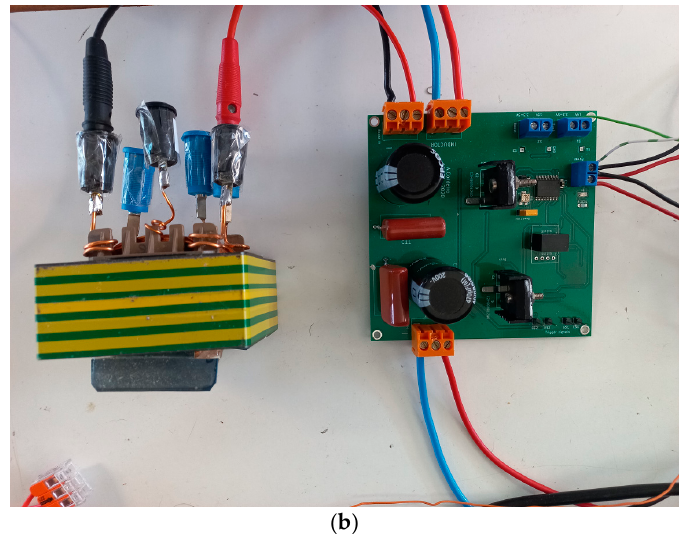
Figure 12. Experimental setup of the proposed system; ( a ) general overview of the prototype, 1— DC power source, 2—power source to supply control circuit, 3—signal generator, 4—multimeter, 5—oscilloscope, 6— PLC AXC1050 controller from Phoenix Contact, 7—microchip DSP microcontroller 30F4012, 8—first DC–DC converter, 9—second DC–DC converter, 10—third DC–DC converter; 11—voltage sensor PCB, 12—current sensor PCB , 13—inductors; ( b ) detail of the DC–DC power converter and inductor adopted.